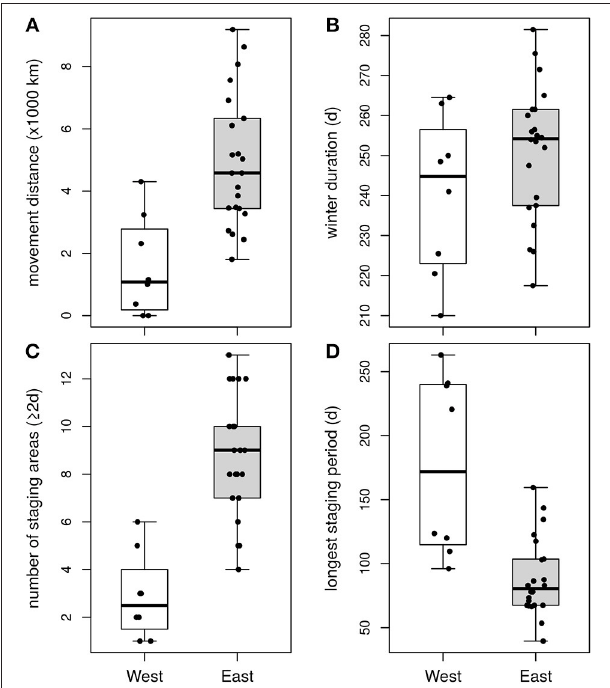
FIGURE 4 | Characteristics of winter movements of red-necked phalaropes wintering in the Pacific (“West”, white boxes) and the Arabian Sea (“East”, gray boxes): cumulative distance between staging areas (A) , duration of the wintering period (B) , number of staging areas (C) , and duration of the longest staging period (D)